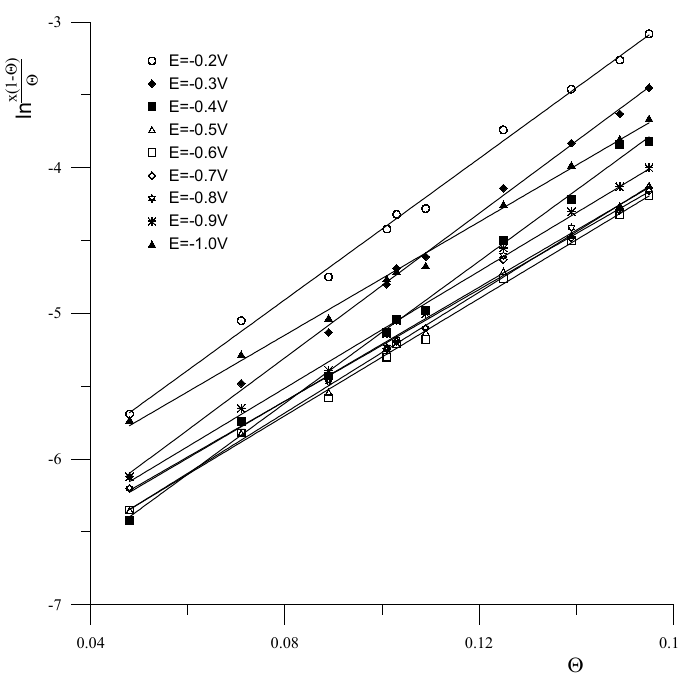
Figure 4. A linear test of the Frumkin isotherm for the system 3 mol dm -3 NaClO